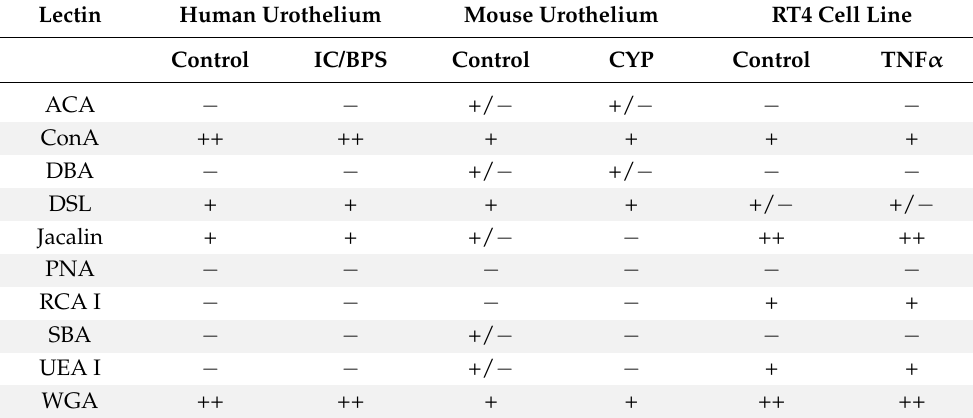
Table 2. The results of semi-quantitative assessment of lectin binding in normal and IC/BPS human urothelium, control and CYP-treated mouse urothelium, and control and TNF α -treated RT4 cells. Legend: ++ (very intense), + (intense), +/ − (weak), or − (very weak).